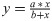
Effects of cangrelor and eptifibatide on the dose-dependent changes of AUC and Amax of the LDF recordings in mice administered with the increasing doses of ADP.Data is presented as mean ± SEM; n = 7–9 mice. Animals were pre-injected with various doses of either cangrelor (A) (black circle- 0 mg/kg b.w., open circle- 0.2 mg/kg b.w., grey diamond- 1 mg/kg b.w.) or eptifibatide (B) (black circle- 0 mg/kg b.w., open circle- 0.5 mg/kg b.w., grey diamond- 4 mg/kg b.w.), and then administered with boluses of increasing doses of ADP. The curve was fitted to the one-site binding non-linear regression curve (GraphPad Prism ver. 5.0): y=a*xb+x, where ‘a’ is the maximum achievable AUC and ‘b’ is the concentration of the agonist (ADP), at which the response reaches 50%. Cangrelor: shared a = 1025 ± 111, b control = 1.12 ± 0.43; b cangrelor 0.2 mg/kg b.w. = 8.69 ± 2.37; b cangrelor 1 mg/kg b.w. = 6.34 ± 1.83; p < 0.0001 for comparing of all curves, p < 0.001 for bcontrol < bcangr 0.2 = bcangr 1; based on extra sum-of-squares F-statistics and the multiple comparison testing with the use of Bonferroni’s correction. Eptifibatide: shared a = 1104 ± 129, b control = 1.38 ± 0.54; b eptifibatide 0.5 mg/kg b.w. = 3.87 ± 1.23; b eptifibatide 4 mg/kg b.w. = 9.66 ± 2.94; p < 0.0001 for comparing of all curves, p < 0.001 for bcontrol < bcangr 0.5 < bcangr 4; based on extra sum-of-squares F-statistics and the multiple comparison testing with the use of the Bonferroni’s correction.